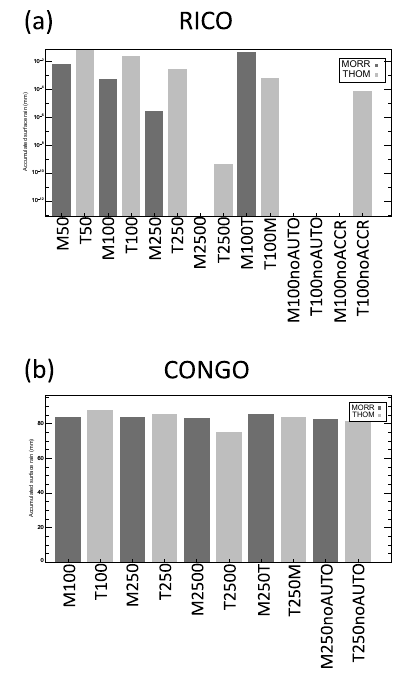
Figure 13. Total accumulated surface rain (mm) for each of the microphysics simulations, including a series of sensitivity simula- tions, for (a) the RICO case total after 24h of simulation and (b) the Congo case total over the period 1–10 August 2007. Note that because the magnitude of the rain response to CDNC differs so strongly between the configurations in the RICO case, a logarith- mic vertical axis is used in panel (a) . The horizontal dashed line in panel (b) indicates the total precipitation from the TRMM 2A25 product over the same